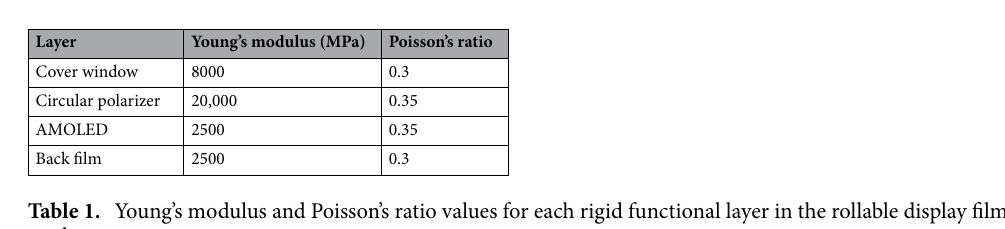
Table 1. Young’s modulus and Poisson’s ratio values for each rigid functional layer in the rollable display film stacks.